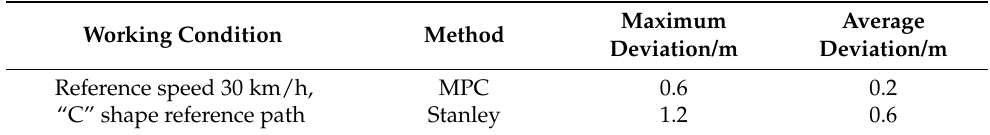
Table 1. Lateral error test results.